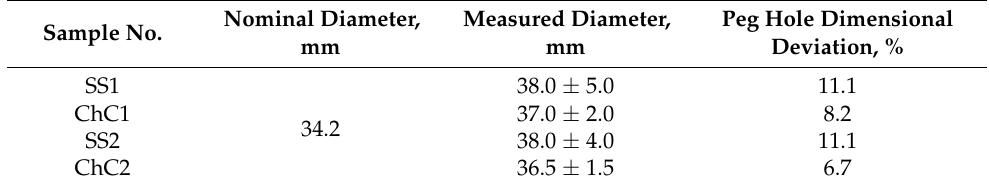
Table 3. Measurements of dimensional wear in the region of peg hole of the particular samples. Sample